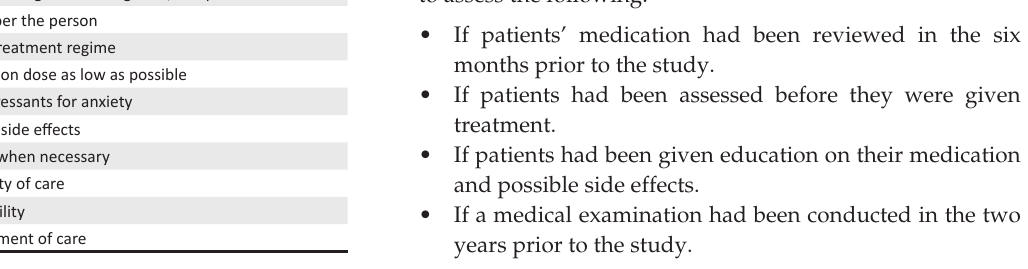
TABLE 2: Classification and services in uThungulu District. Local municipality District hospital Total number of PHC